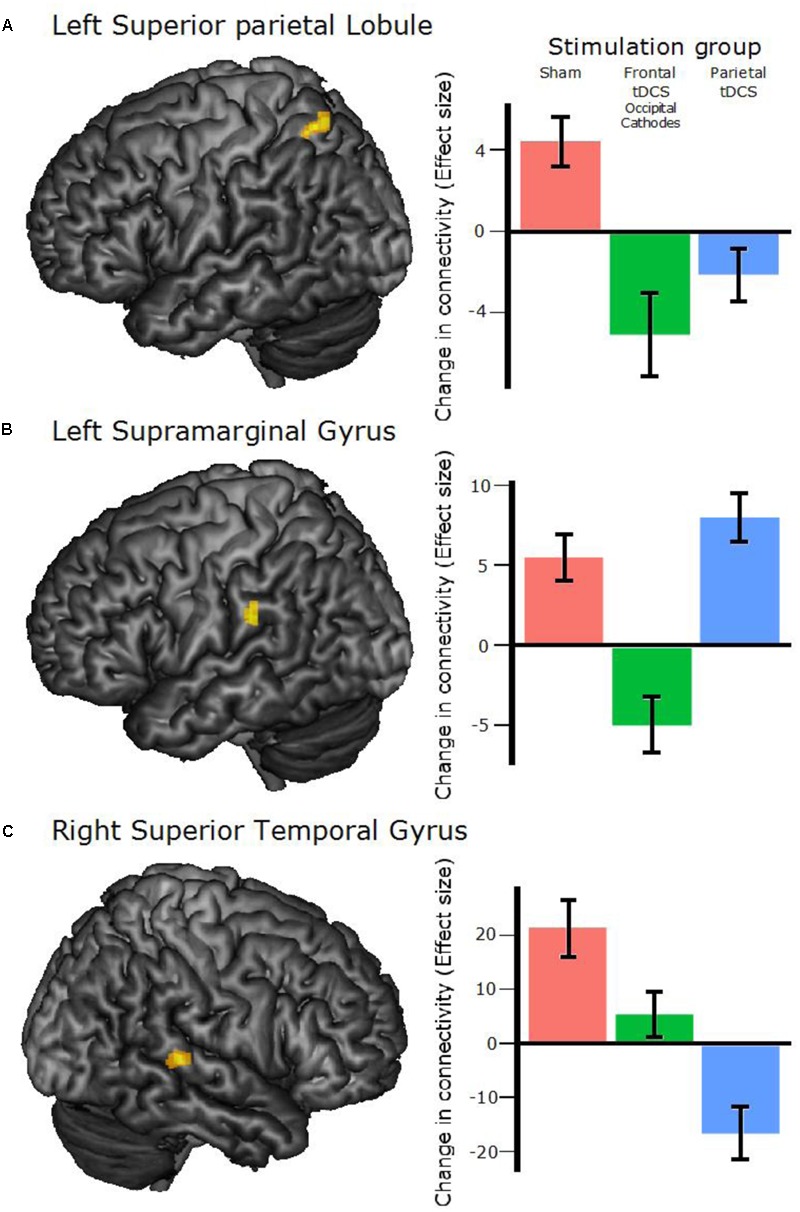
Clusters found to differ between groups and between pre–post scans. (A) The left Superior Parietal Lobule cluster, peak coordinates: –24 –60 +60 (all coordinates are in MNI space). (B) The left Supramarginal Gyrus cluster, peak coordinates: –50 –30 +26. (C) The right Superior Temporal Gyrus cluster, peak coordinates: +52 –34 +06. Right panel: The bar plots show effect sizes from the voxel-to-voxel multivariate pattern analysis (MVPA) with any Group differences and Post–Pre as contrasts. The bars correspond to the mean of all the voxels within the corresponding cluster and all participants in the specified stimulation group. Error bars show 95% confidence interval. The unit on the y-axis is arbitrary.